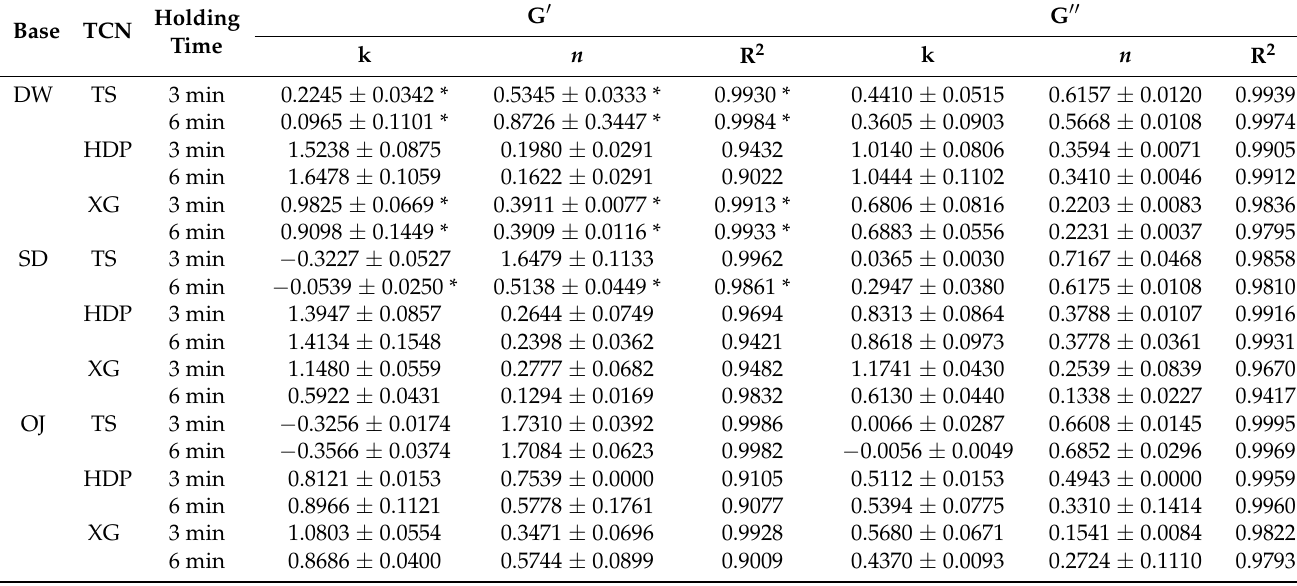
Table 5. Linear regression outputs of equation G (cid:48) = kw n in log scale for thickened fluid with different combinations of continuous bases, thickeners (TCN), and processes with the frequency range between 0.1 and 10 Hz. G Holding Base TCN Time